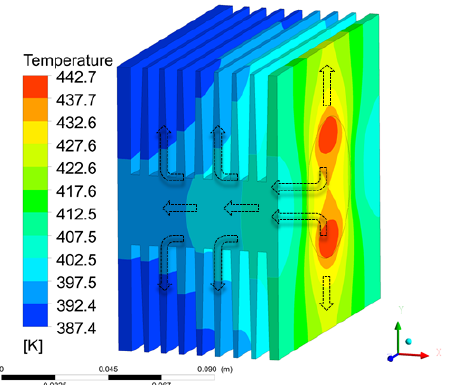
Fig. 12. Temperature field distribution and temperature transfer